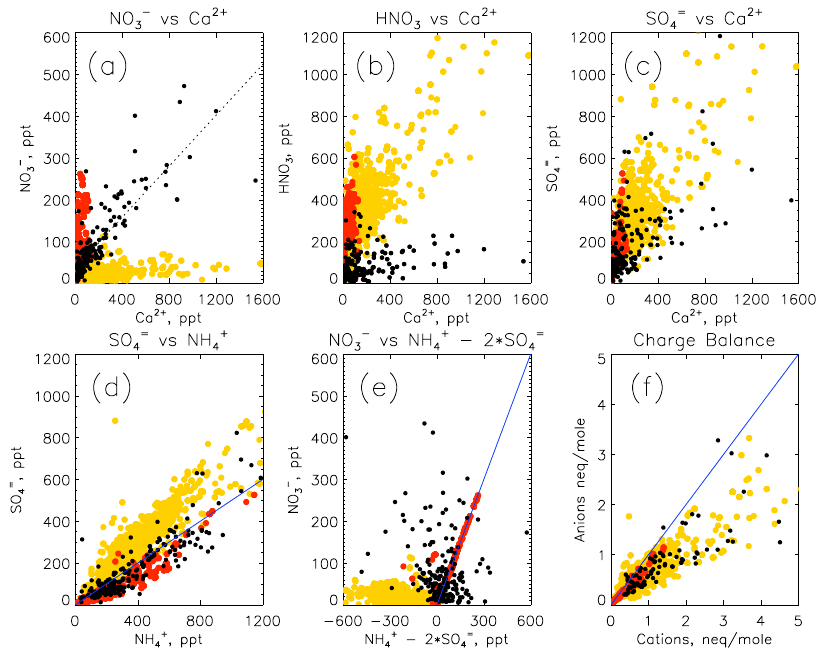
Fig. 4a. Relationships between bulk aerosol components and HNO 3 (g) concentrations along the INTEX-B flight tracks, excluding data below 1km or in the stratosphere. Observations are shown in black, with each data point corresponding to an aerosol sample along the tracks shown in Fig. 2. Model values not including acid uptake by dust are shown in color, separately for dusty ([Ca 2 + ] > 2[NO − ]; yellow) and 3 non-dusty ([Ca 2 + ] < 2[NO − ]; red conditions. The bottom right panel shows the equivalent balance between the sum of measured cations 3 (Ca 2 + , Mg 2 + , K + , Na + , NH + ) and the sum of measured anions (SO 2 − , NO − , Cl − ). The black line in panel (a) shows the linear best fit to 4 4 3 the observations; blue lines in panels (d) , (e) , and (f) , show the 1:2, 1:1, and 1:1 relationships, respectively.